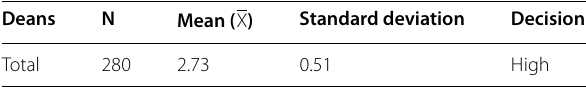
Table 1 The Deans’ mean response ratings on awareness of the need for quality assurance in the university